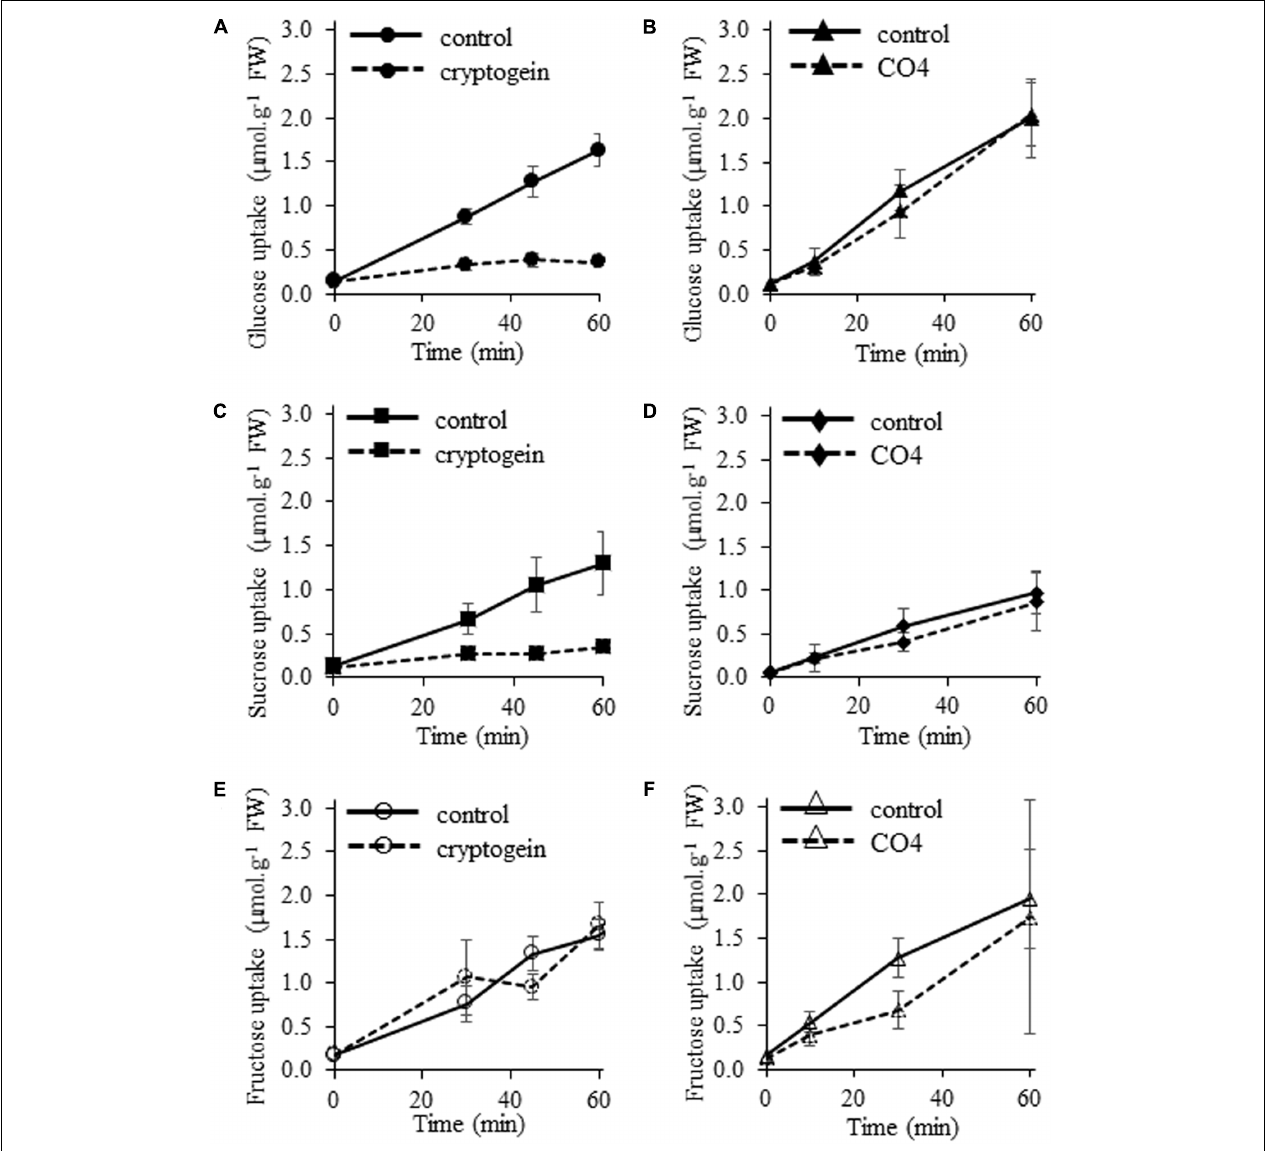
FIGURE 4 | Effects of cryptogein and CO4 on glucose, sucrose, and fructose uptake in tobacco cells. (A,B) Time course of 14 C-glucose uptake. (C,D) Time course of 14 C-sucrose uptake. (E,F) Time course of 14 C-fructose uptake. For all experiments, cells were pre-incubated with 2 mM 14 C-sugar (0.055 MBq.g - 1 FW cells),